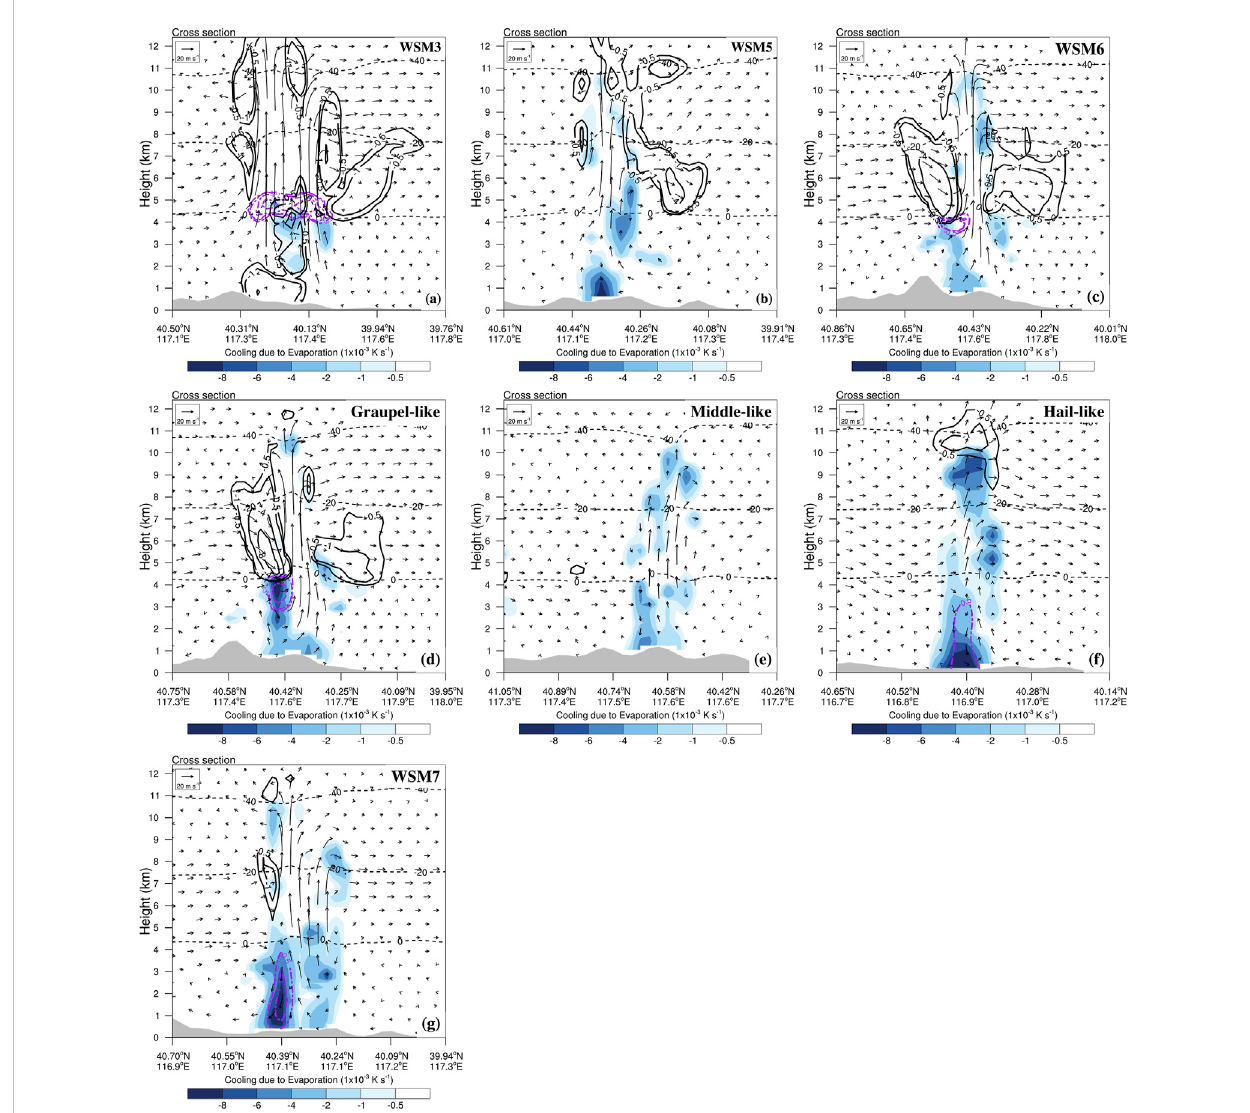
FIGURE 15 Vertical cross sections (along the black line in Figure 6) of cooling source from evaporation (shaded; 10 − 3 K s − 1 ), sublimation (black solid lines; 10 − 3 K s − 1 ) and melting (purple dashed lines; 10 − 3 K s − 1 ) superimposed instantaneous fl ow with the isotherm lines (black dashed lines; Isopleth interval is 20 ° C) at convective development stage for all seven experiments: (A) WSM3, (B) WSM5, (C) WSM6, (D) WSM6-Graupel-Like, (E) WSM6-Middle-Like, (F) WSM6- Hail-Like and (G) WSM7 experiments. The grey areas indicate the terrain